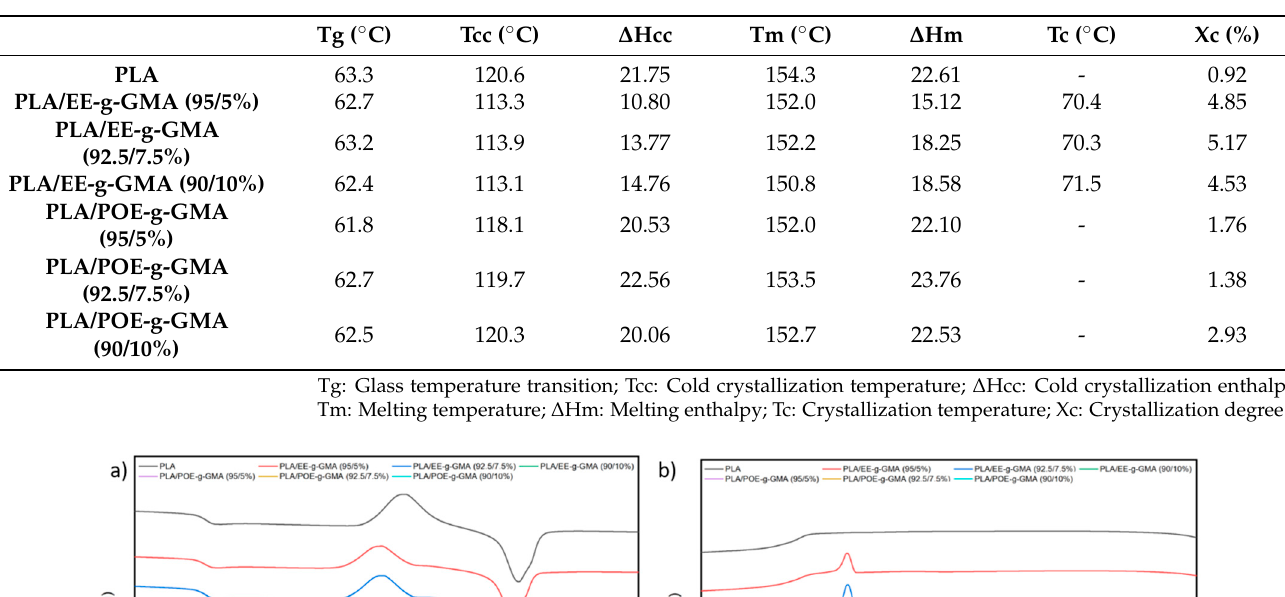
Table 2. Data obtained in the DSC of the compositions.